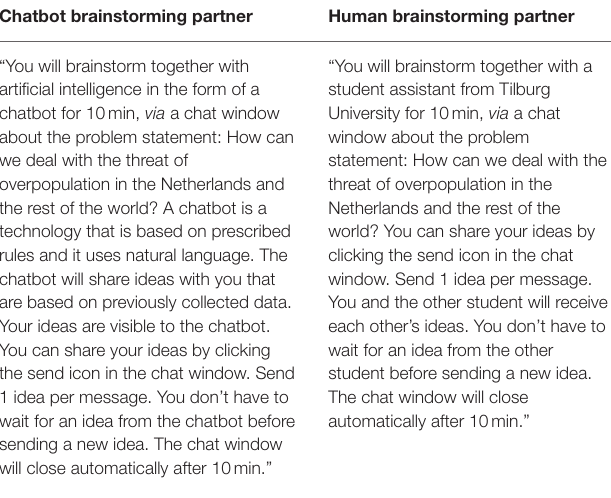
TABLE 1 | The introduction (framing) of the brainstorming